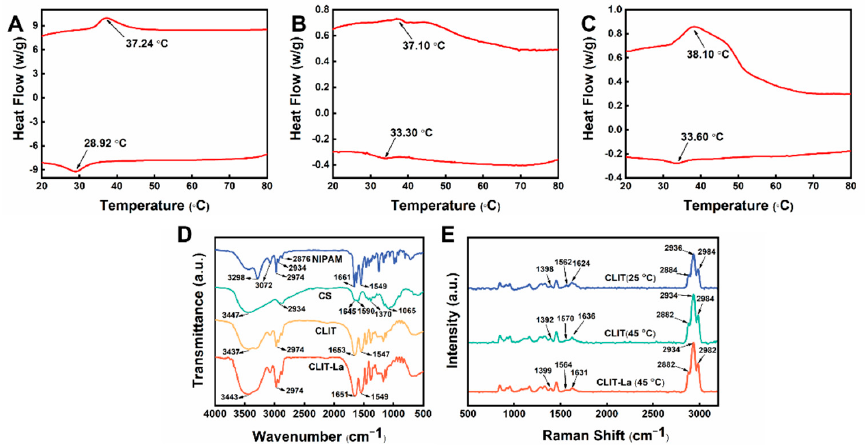
Figure 2. DSC curves of CLIT during repeated tests (the first test ( A ), second test ( B ), and third test ( C )); FTIR spectra of CS, NIPAM, CLIT, CLIT-La ( D ); Raman spectra of hydrogels CLIT (25 °C), CLIT (45 °C), CLIT-La (45 °C) ( E ).